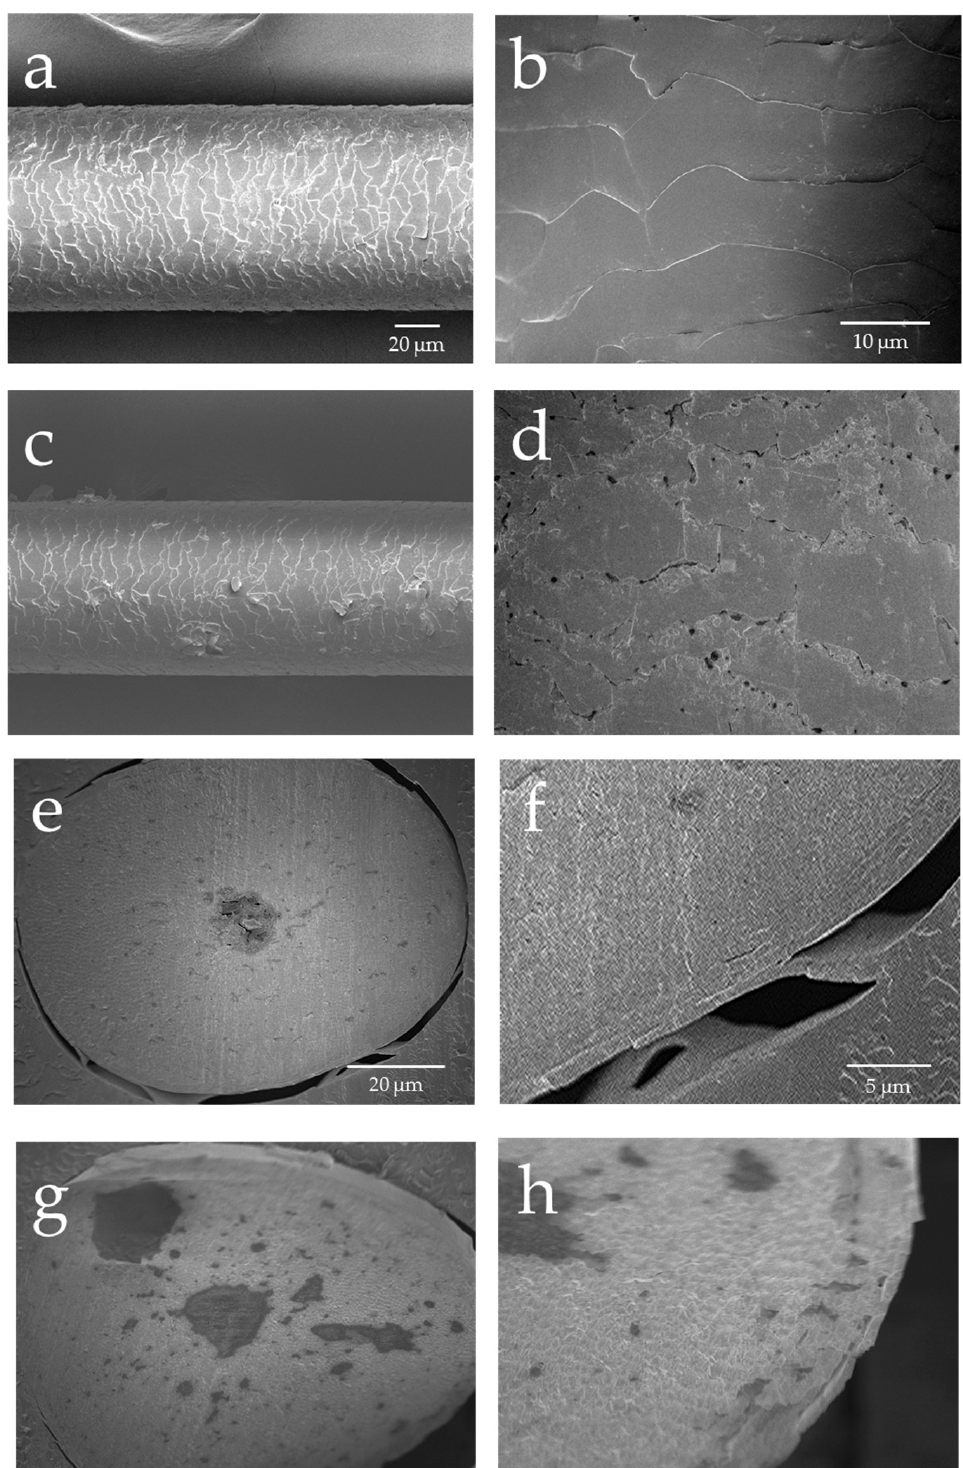
Figure 1. Field emission scanning electron microscope (FE-SEM) images of the surface and cross-section of hair not exposed to ultraviolet (UV) radiation and hair exposed to UV radiation. Images of the surface of hair not exposed to UV radiation, ×500 ( a ) and ×2000 ( b ); images of the surface of hair exposed to UV radiation, ×500 ( c ) and ×2000 ( d ); images of the cross-section of hair not exposed to UV radiation, ×1000 ( e ) and ×3200 ( f ); images of the cross-section of hair exposed to UV radiation, ×1000 ( g ) and ×3200 ( h ).